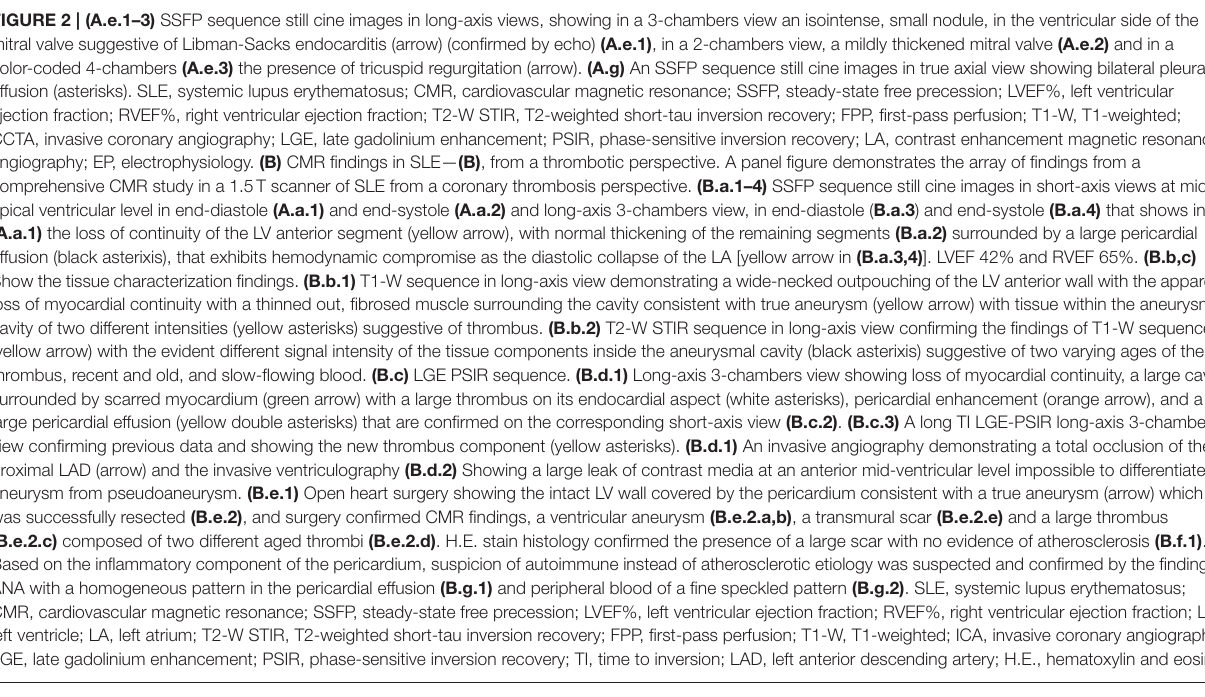
FIGURE 2 | (A.e.1–3) SSFP sequence still cine images in long-axis views, showing in a 3-chambers view an isointense, small nodule, in the ventricular side of the mitral valve suggestive of Libman-Sacks endocarditis (arrow) (confirmed by echo) (A.e.1) , in a 2-chambers view, a mildly thickened mitral valve (A.e.2) and in a color-coded 4-chambers (A.e.3) the presence of tricuspid regurgitation (arrow). (A.g) An SSFP sequence still cine images in true axial view showing bilateral pleural effusion (asterisks). SLE, systemic lupus erythematosus; CMR, cardiovascular magnetic resonance; SSFP, steady-state free precession; LVEF%, left ventricular ejection fraction; RVEF%, right ventricular ejection fraction; T2-W STIR, T2-weighted short-tau inversion recovery; FPP, first-pass perfusion; T1-W, T1-weighted; CCTA, invasive coronary angiography; LGE, late gadolinium enhancement; PSIR, phase-sensitive inversion recovery; LA, contrast enhancement magnetic